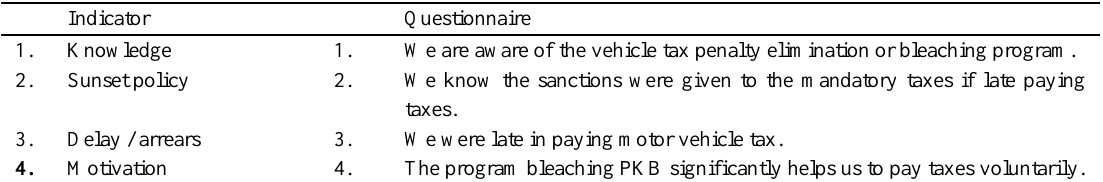
Table 2: Variable Indicators of Motor Vehicle Tax Bleaching